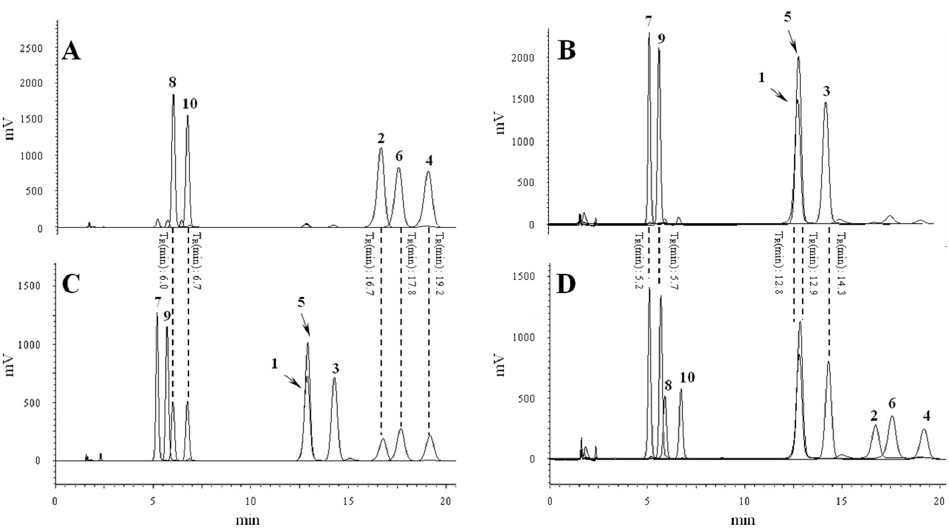
Figure 2. Overlaid HPLC-UV chromatograms obtained at 210 nm of ( A ) isolated trans -compounds with purities of ≥ 95%; ( B ) isolated cis -compounds with purities of ≥ 95%; ( C ) fully converted mixtures from trans -compounds after 96 h of UV exposure and ( D ) fully converted mixtures from cis -compounds after 96 h of UV (254 nm) exposure.